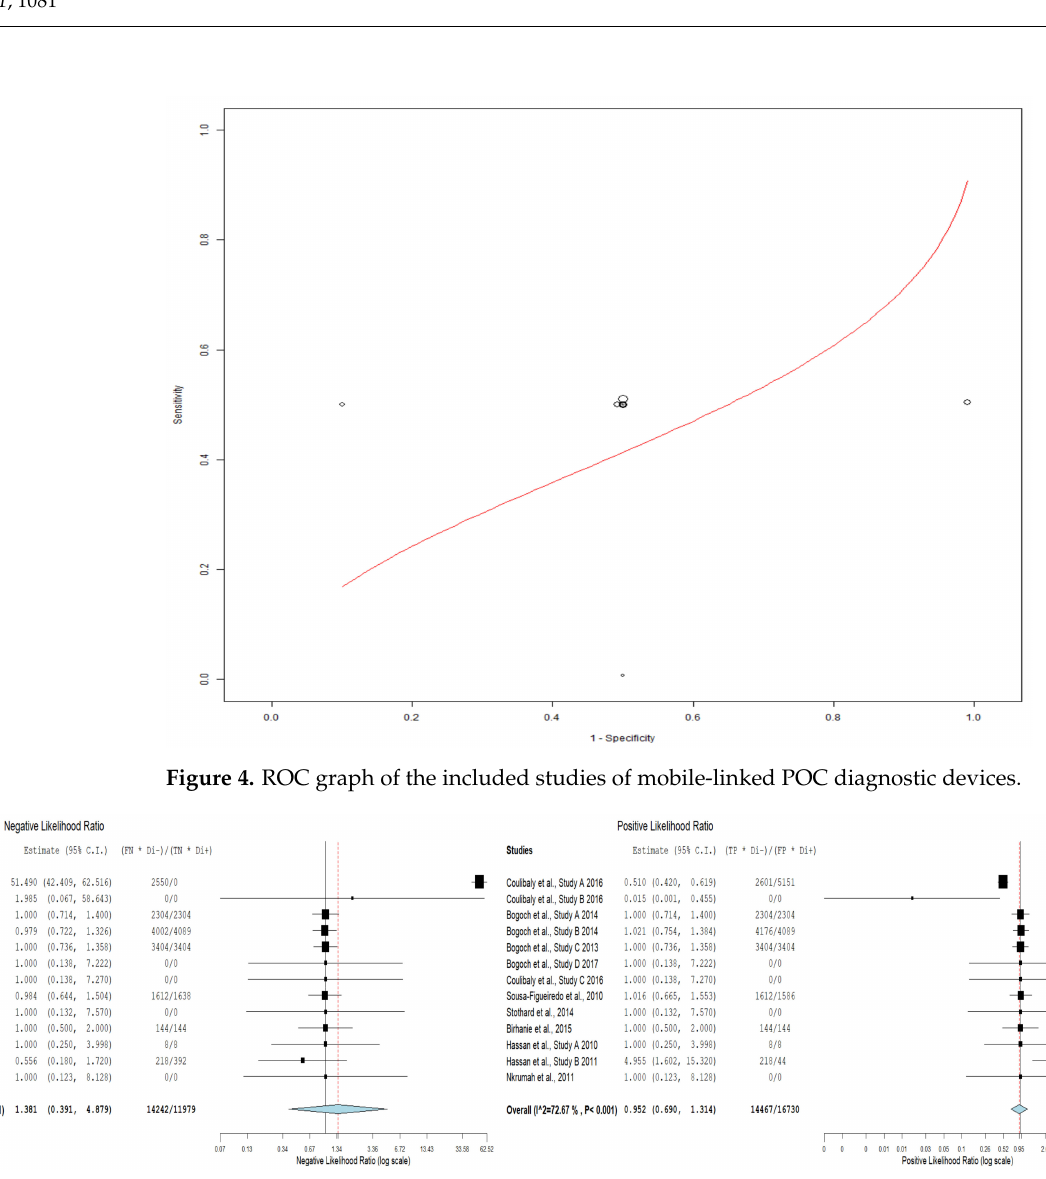
Figure 5. Negative likelihood ratio and positive likelihood ratio of the included studies of the mobile-linked POC diagnos- tic devices.